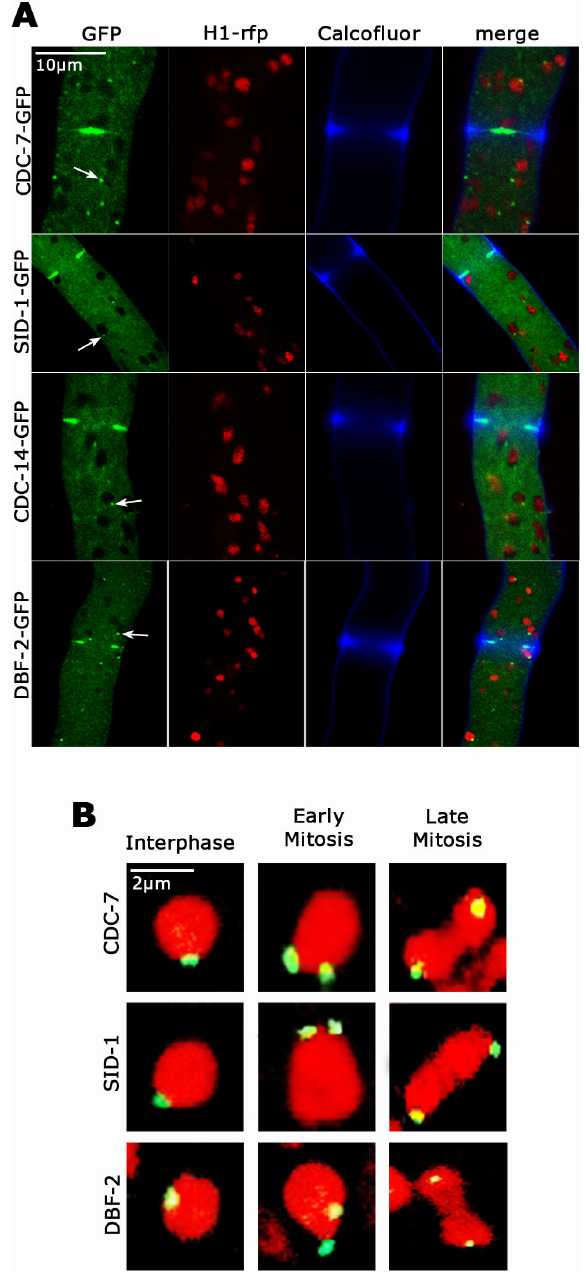
Figure 2. N. crassa SIN components localize to SPBs and septa (A). Functional GFP fusion proteins of CDC-7, SID-1, CDC-14 and DBF-2 localized to spindle pole bodies (arrows) and as constricting rings at forming septa. Nuclei were labeled with histone H1-RFP, the cell wall was stained with Calcofluor White. ( B ) The localization of the three SIN kinases CDC-7, SID-1 and DBF-2 to SPBs is constitutive and cell cycle independent. The three SIN kinases associate with SPBs of interphase nuclei as well as during early and late mitotic stages (as indicated by nuclear morphology). Nuclei were labeled with histone